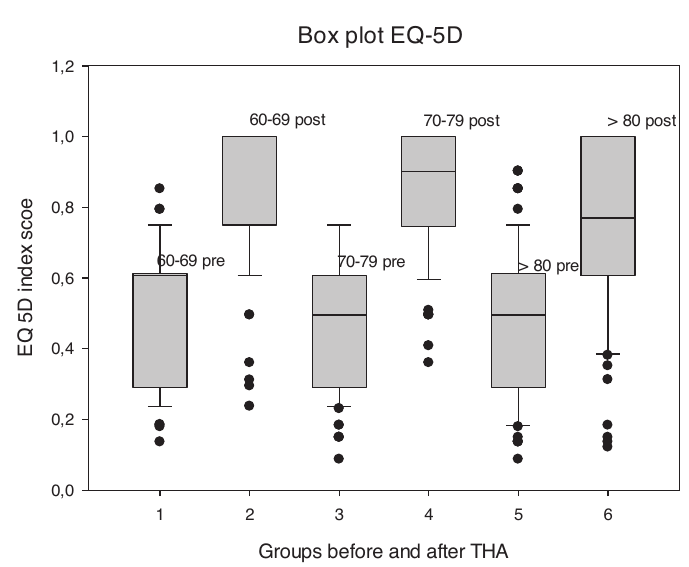
Figure 2. Box plot EQ-5D.